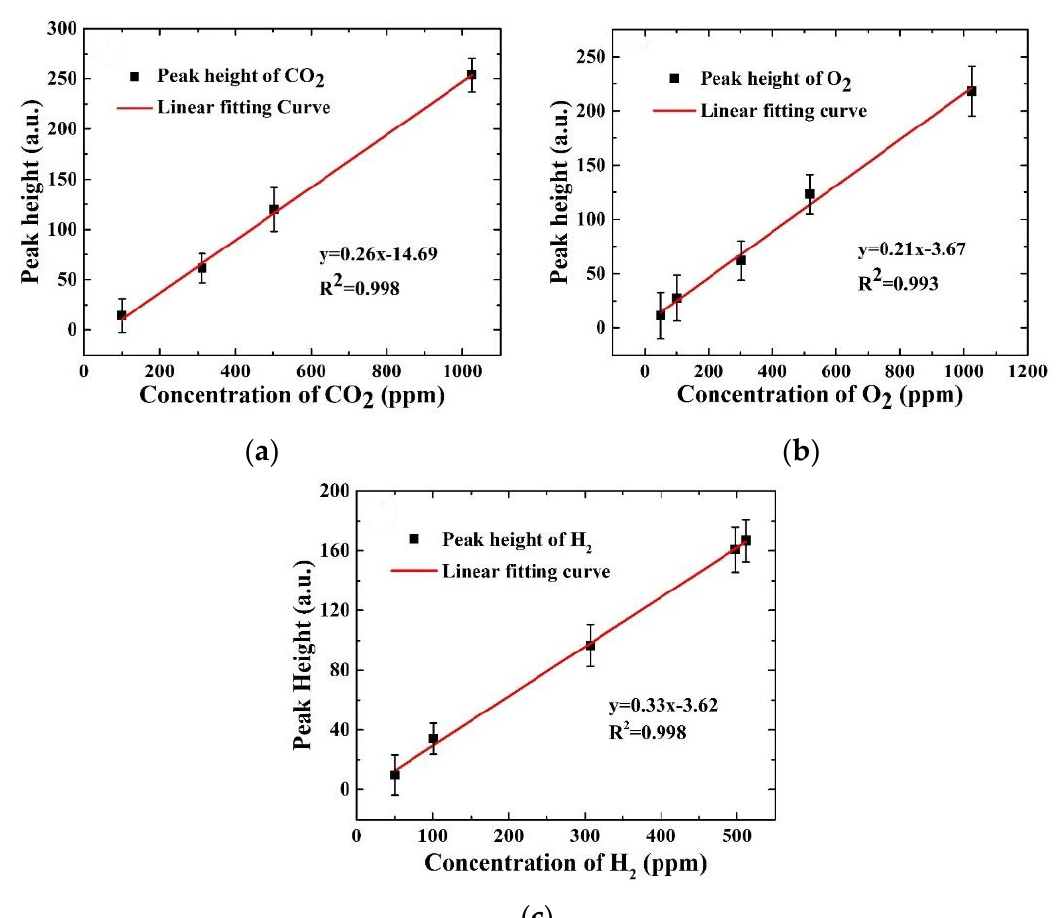
Sensors 2021 , 21 , x FOR PEER REVIEW Figure 4. Linear relationships between concentrations and peak intensity of CO 2 ( a ), O 2 ( b ), and H 2 ( c ). Figure 4. Linear relationships between concentrations and peak intensity of CO